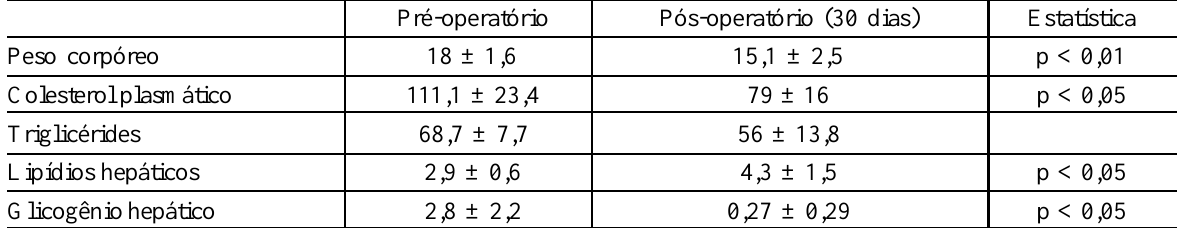
TABELA 2 - Resultados do Grupo